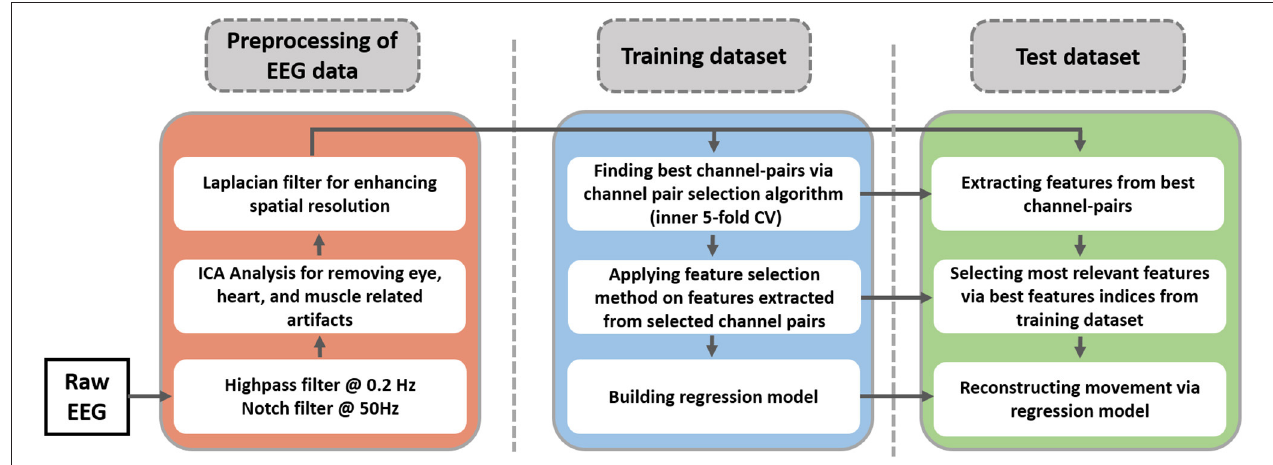
FIGURE 3 | Schematic of proposed EEG data processing pipeline. The blue and the green parts indicate the training and test dataset of outer cross-validation (10-fold